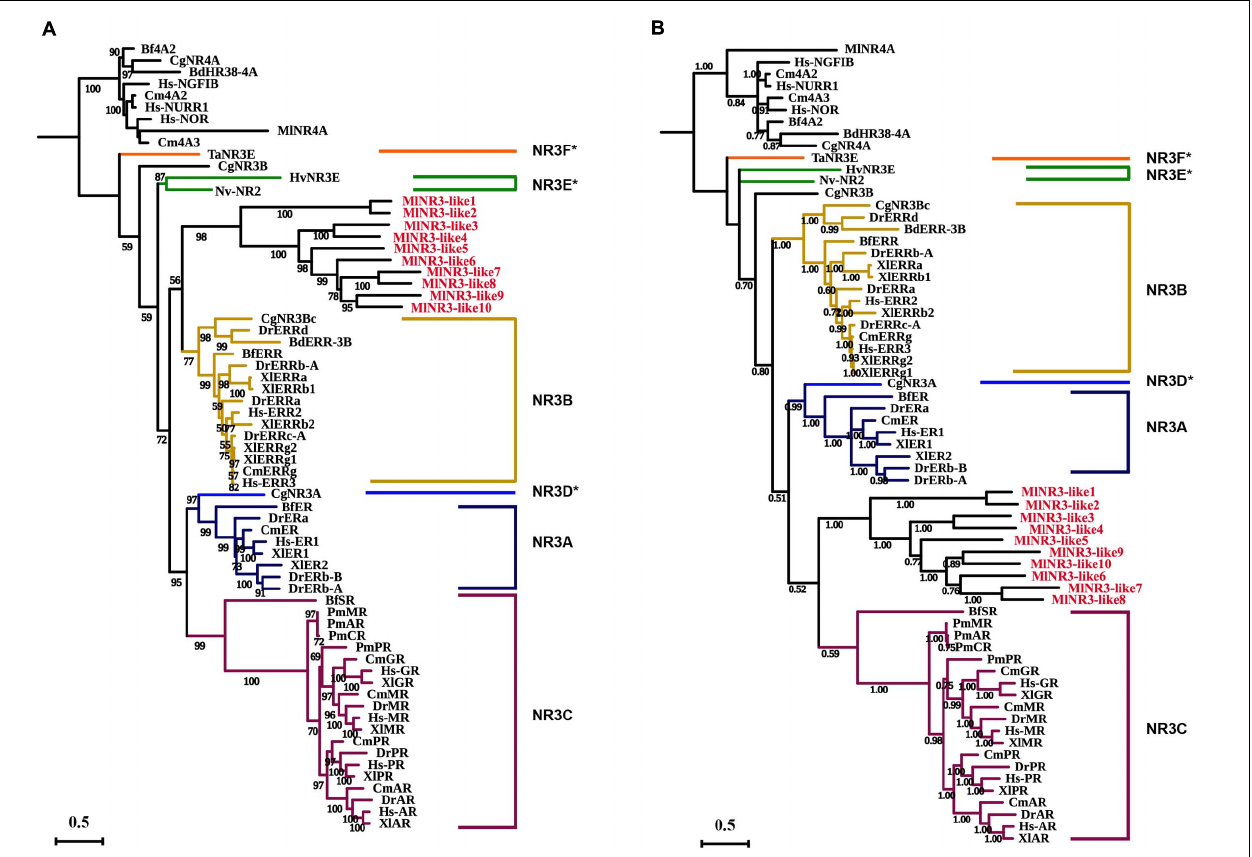
FIGURE 2 | Phylogenetic analyses of the NR3 subfamily. (A) ML phylogenetic tree constructed by the IQTREE procedure. (B) Bayesian phylogenetic tree by the software MrBayes 3.2. The numbers on the branch indicate the likelihood ratio test branch support values. Aq, Amphimedon queenslandica; Ta, Trichoplax adhaerens ; Hv, Hydra vulgaris ; Nv, Nematostella vectensis ; Cg, Crassostrea gigas, Bd, Bactrocera dorsalis; Bf, Branchiostoma floridae ; Cm, Callorhinchus milii ; Xt, Xenopus tropicalis ; Dr, Danio rerio ; Hs, Homo sapiens ; Ml, M. lignano . NR3D*, NR3E*, and NR3F* represent the ER-like genes from the protostomia, cnidarian, and placozoa, respectively (Miglioli et al., 2021). All NR3-like genes from M. lignano were in